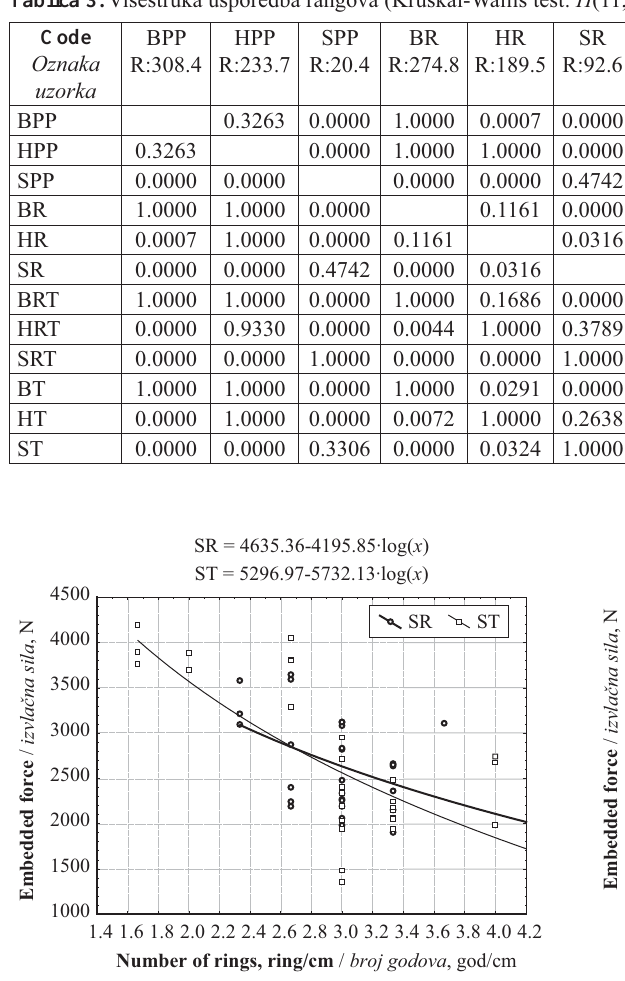
Figure 5 Infl uence of the number of growth rings (BRT and HRT) on embedded